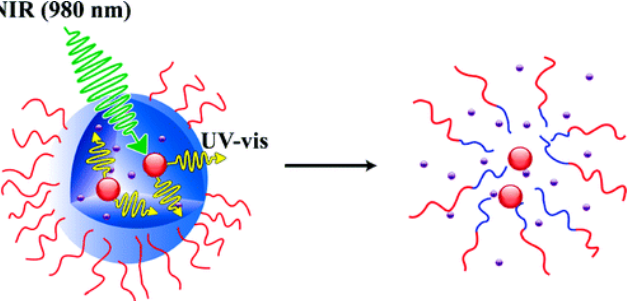
Figure 10. Schematic representation of NIR to UV light conversion via UCNP inside a block copolymer micelle and resulting release of encapsulated guest molecules. Reproduced with permission from Ref. [175]. Copyright 2011 American Chemical Society.